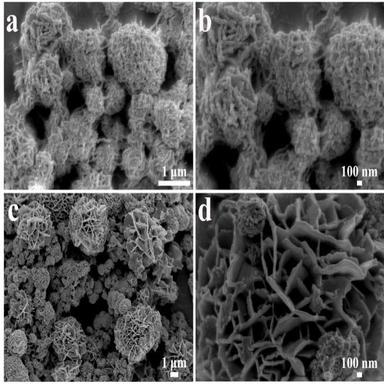
SEM images of Ni-MOFs/MWCNTs (a,b) and N/NC-10 (c,d) at different magnifications.